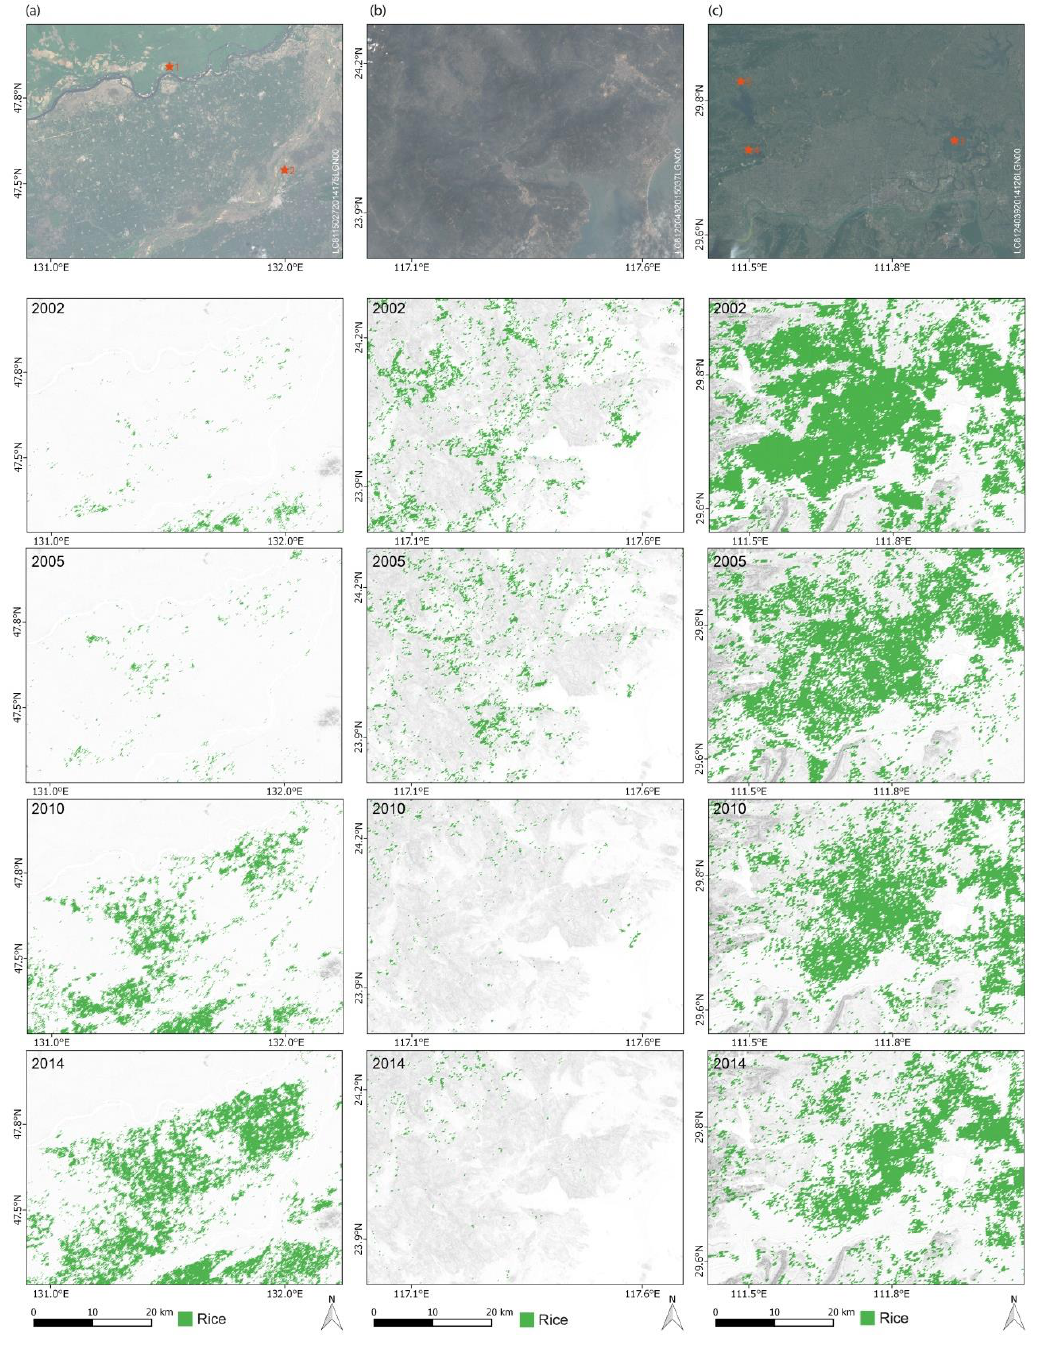
Figure 8. Rice area changes in ( a ) Heilong Jiang Plain, Heilongjiang province, ( b ) Dongshan Bay, Fujian province, and ( c ) Beimin Lake, Hunan province. Landsat 8 RGB overview images are presented in the first row; the next four rows are based on the OCSVM classification, with slope relief derived from the Shuttle Radar Topography Mission (SRTM, 1 arc-second) Digital Elevation Modelas the background. Red stars show bifurcations of the Heilong Jiang (1) and Songhua Jiang (2) rivers, the plain at Beimin Lake (3), the southern part of Guanting Reservoir (4) and Wangjiachang Reservoir (5).